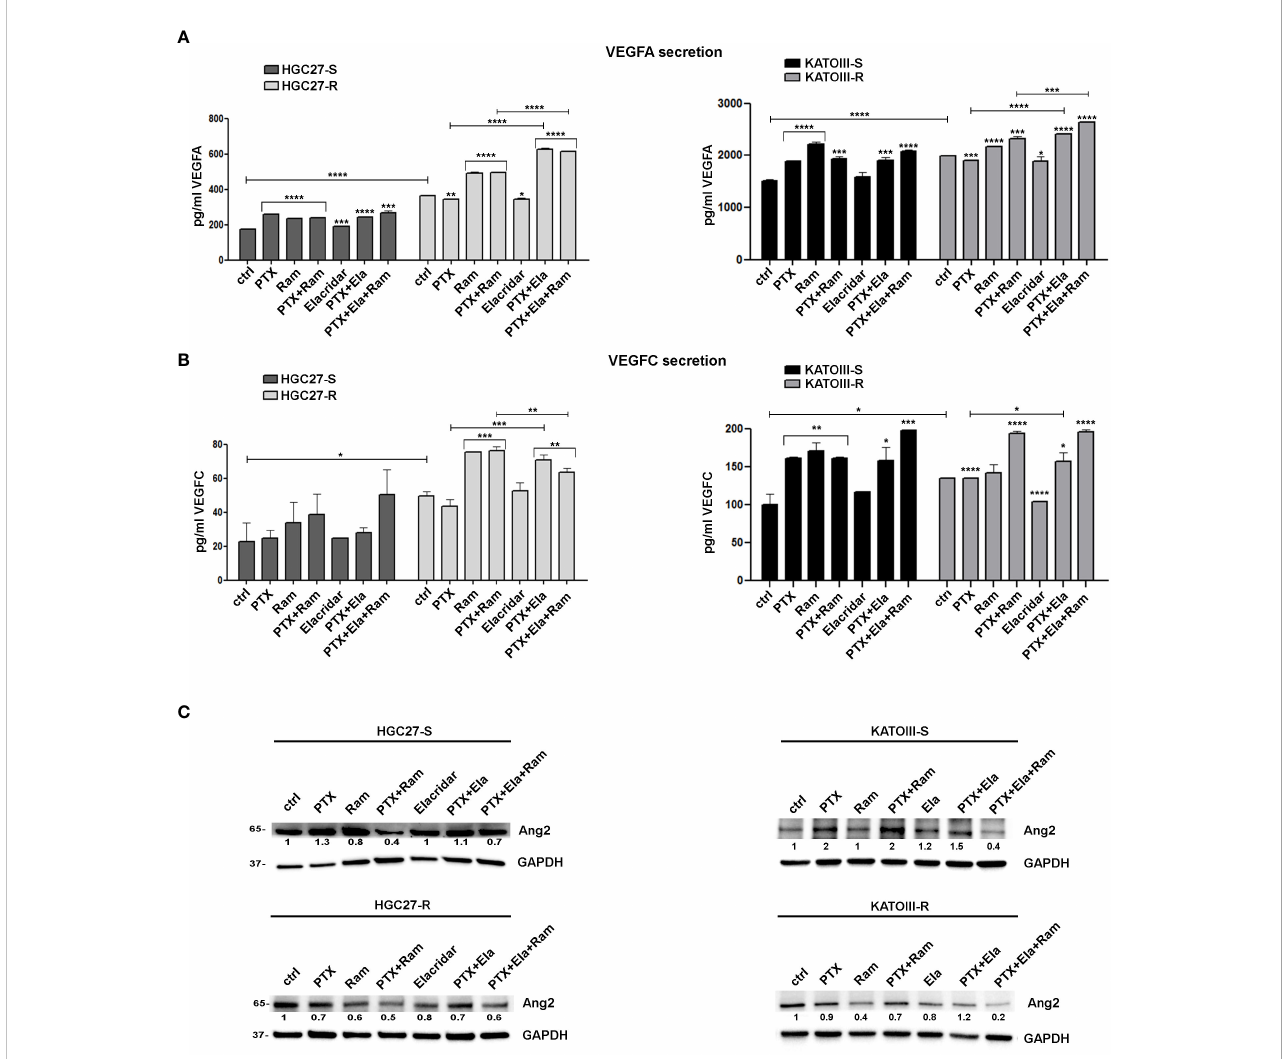
FIGURE 6 The effects of PTX and Ramucirumab on VEGFA/VEGFC secretion. The ELISA assays were assessed on HGC27-S/R and KATOIII-S/R treated with 4 nM PTX (HGC27) or 2 nM PTX (KATOIII), 100 m g/mL Ramucirumab (Ram) and 100 nM Elacridar (Ela) alone or in combination. The concentration of VEGFA (A) or VEGFC (B) was determined in the medium and normalized for the cell number. The values ± SD, obtained from three independent experiments expressed as pg/mL were shown in the relative graphs. Statistical analysis was assessed comparing the values obtained using single drug treatment to those of corresponding untreated cells and the combined treatments to those of the single treatments. The values of untreated PTX-resistant cells were compared with those of untreated PTX-sensitive ones, *p < 0.05; **p < 0.01; ***p < 0.001; ****p < 0.0001. (C) Representative Western Blotting analysis performed in HGC27-S/R and KATOIII-S/R cells relative to the expression of Ang2. Nuclear protein extracts have been normalized using stain free technology. GAPDH has been used as a normalizer of cytoplasmic protein extracts. Values indicating normalized expression levels are shown on each